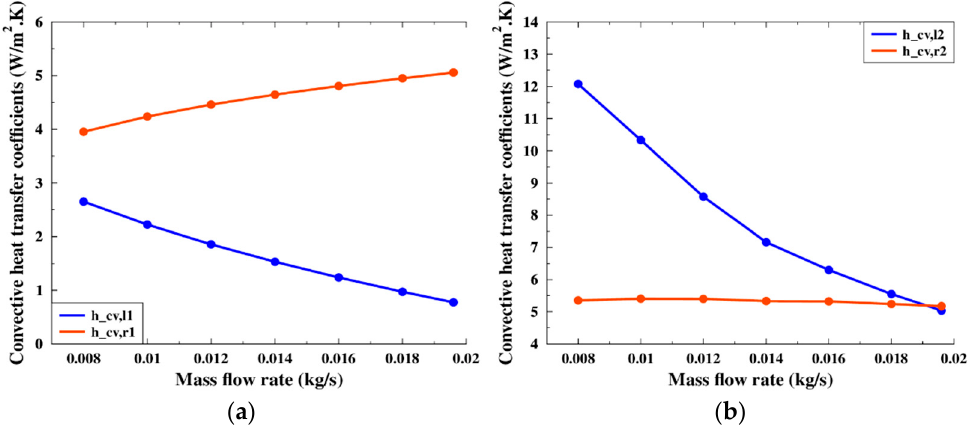
Figure 8. Convective heat transfer coefficients in the ( a ) outer gap and ( b ) inner gap.